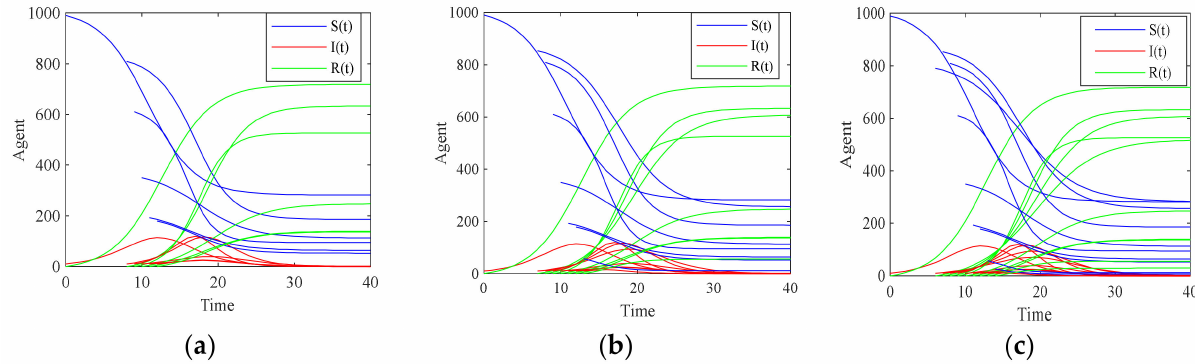
Figure 9. Evolution of initial public opinion and subtopics under different information alienation settings. ( a ) ρ = 0.75. ( b ) ρ = 0.85. ( c ) ρ = 0.95.